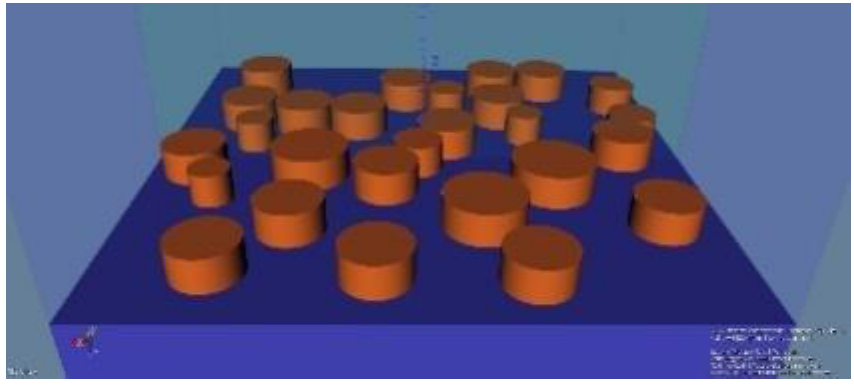
Figure 2. The supercell with a random distribution of nanopillars. Considering the experimental results (see Section 3.2) we selected to numerically investigate the electromagnetic field enhancement obtained with a random metasurface with silver meta-atoms. The height of the simulated meta-atoms is 60 nm the average height of silver nanostructures measured from SEM characterizations, and the selected diameters are between 70 nm and 150 nm. The FDTD simulations were performed using continuous wave (CW) at specific wavelengths from the absorption and emission spectra of Rhodamine 6G. Employing the average field enhancement between the nanopillars resulted from each simulation we obtained a full spectrum of the electromagnetic field enhancements to demonstrate the origin of the different fluorescence enhancements (Figure 3a). Moreover, Figure 3b,c shows the localized electromagnetic field offered by the metasurfaces. We observed that at 480 nm wavelength (the excitation of R6G employed in our experiments), the electromagnetic field presents a seven fold average enhancement with a maximum of 10 (see Figure 3b). At 550 nm wavelength (the emission of R6G), the field shows an average enhancement of thirteen (Figure 3a) with a maximum enhancement of seventeen (see Figure 3c). We note that the enhancement was considered by averaging over the fields present in the spaces between nanoparticles composing the supercell.